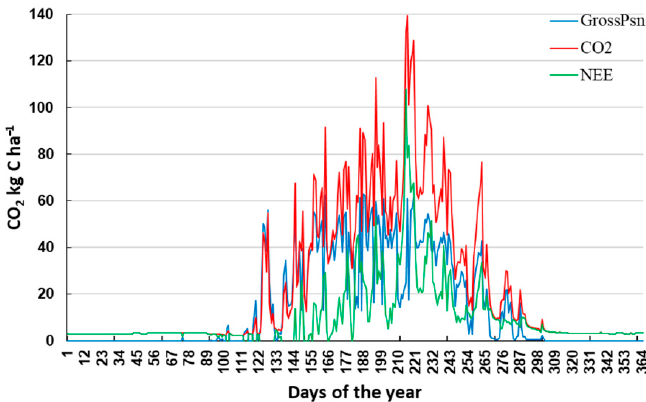
Figure 6. Composite calculated CO 2 fluxes (kg C ha − 1 day − 1 ) of the Great Vasyugan Mire over 2019. Figure 7 shows model estimates of the fluxes constituting the carbon balance RA + RM = CO 2 and GPP = GrossPsn (NEE = CO 2 − GrossPsn). The net annual NEE value was equal to 3397 kg C ha − 1 . The calculated fluxes of CH 4 are illustrated in Figure 8.